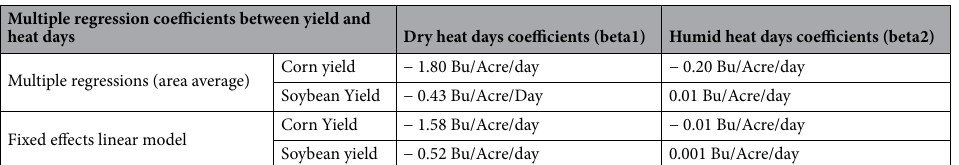
Multiple regression coefficients between yield and heat